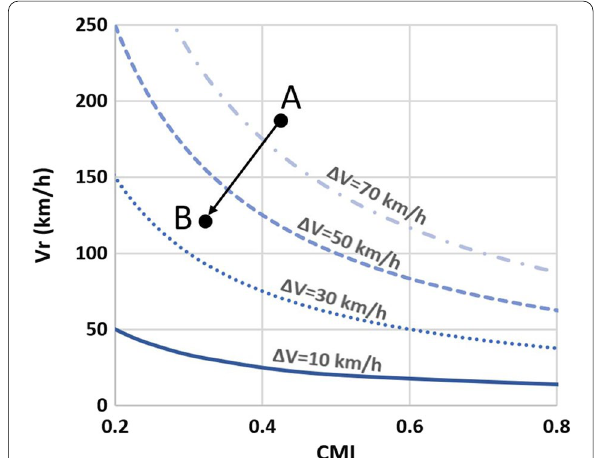
Fig. 2 Example of visualization on the CMI- V r plane, in which iso- (cid:31) V curves are highlighted (equilateral hyperbolas); two types of activation logic are generically visualized, namely no intervention (point A) and an activation on braking and steering (point